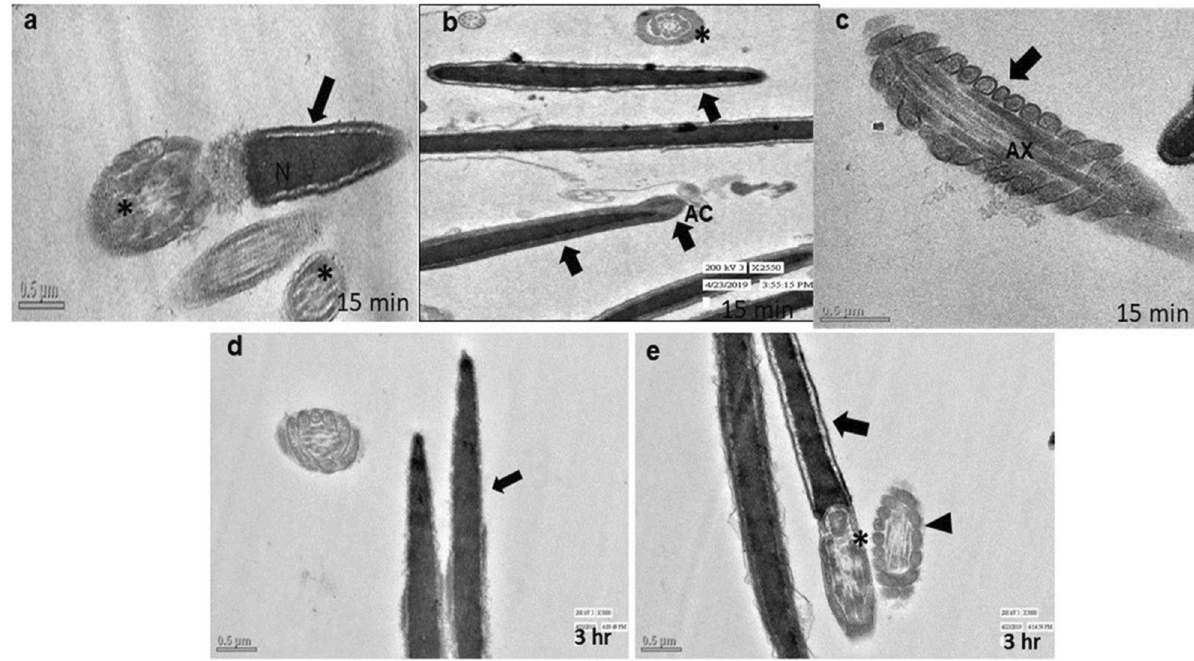
Figure 7. Transmission electron micrographs of the goat spermatozoa of control group after 15 min and 3 h showing intact ultrastructures. ( a ) Longitudinal section of the sperm nucleus; head (arrow; ( a )); axonemal components (star; ( a , b )), ( b ) intact sperm head (arrow) and intact acrosome (AC; ( b )), organized mitochondria (arrow; ( c )), sperm head (arrow; ( d , e ), axonemal components (star; ( e )); organized mitochondria (triangle; ( e )), intact plasma membrane (arrow; ( e )).